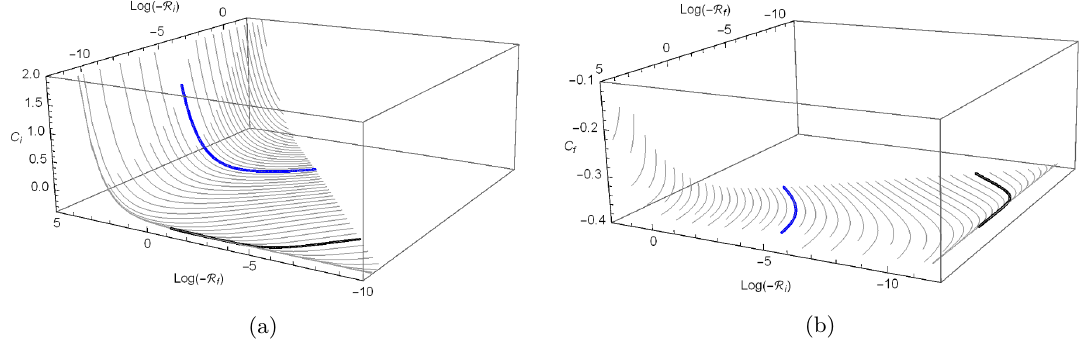
Figure 19 . The dimensionless curvatures vs S 0 , for blue curve with ϕ 0 = 49 , in figure 18a. The horizontal axis is the logarithm of the dimensionless curvature, either ϕ 0 = 69 20 R L or R R .